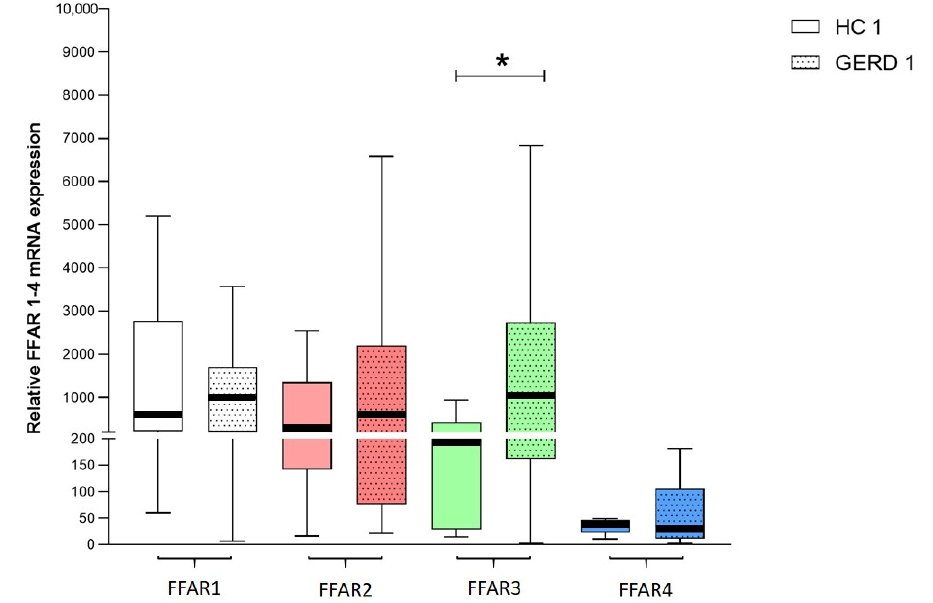
Figure 1. The relative expression of FFAR1, FFAR2, FFAR3, and FFAR4 in healthy controls (HCs) (HC1–4, n = 8) and patients with gastroesophageal reflux disease (GERD) (GERD 1–4, n = 47–51). Expression was compared with the HPRT1 reference gene. The Mann–Whitney test was used to compare the values. * p < 0.05 as compared to respective